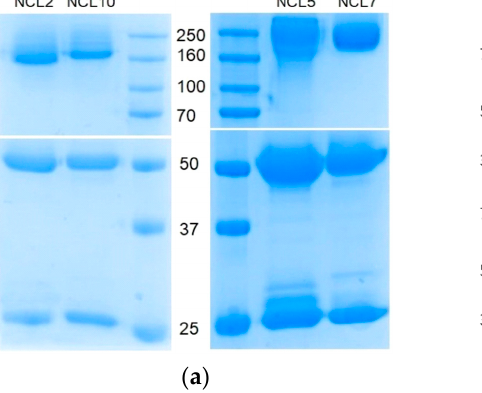
Figure 4. SDS-PAGE ( a ) and Western blot ( b ) analyses of the purified anti-N antibodies. The upper panel of the SDS-PAGE shows the results of the analysis in nonreducing conditions, and the lower panel shows the results of the analysis in the presence of 1% β‐ mercaptoethanol. Detection of native N antigens, which are present in virus ‐ infected cells, using the cell ELISA approach recapitulated the results of the Western blot analysis: while NCL2/5/7 mAbs universally recognized the B.1, P.1 and B.1.1.529 virus ‐ infected cells, the NCL10 antibody was unable to bind to the B.1.1.529 SARS ‐ CoV ‐ 2 ‐ infected cells (Figure 5a). More ‐ over, the OD 450 values, which were determined based on the concentration of the resulting virus–antibody complexes, were different between NCL10 and the three remaining mAbs when identical antibody concentration was used, suggesting that the NCL10 antibody binds with lower intensity to N antigens, probably due to the lower affinity of this bind ‐ ing. An immunocytochemical analysis further demonstrated that NCL10 mAb does not recognize the N protein of the B.1.1.529 VOC (Figure 5b). Future studies with generations